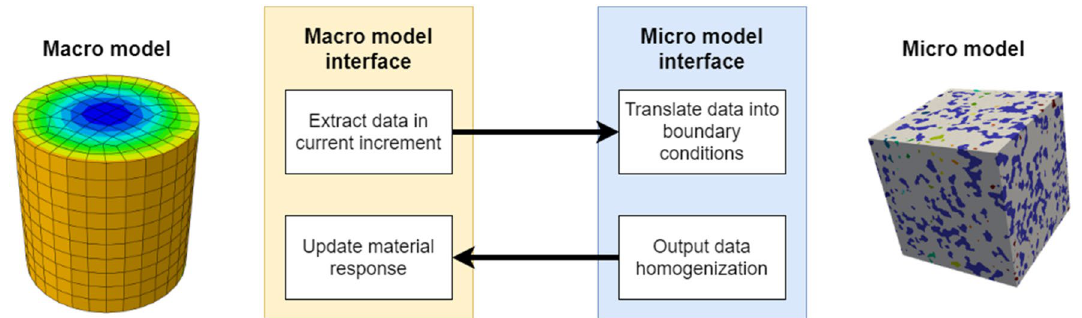
Fig. 2 Concept of the data transfer in a multiscale model